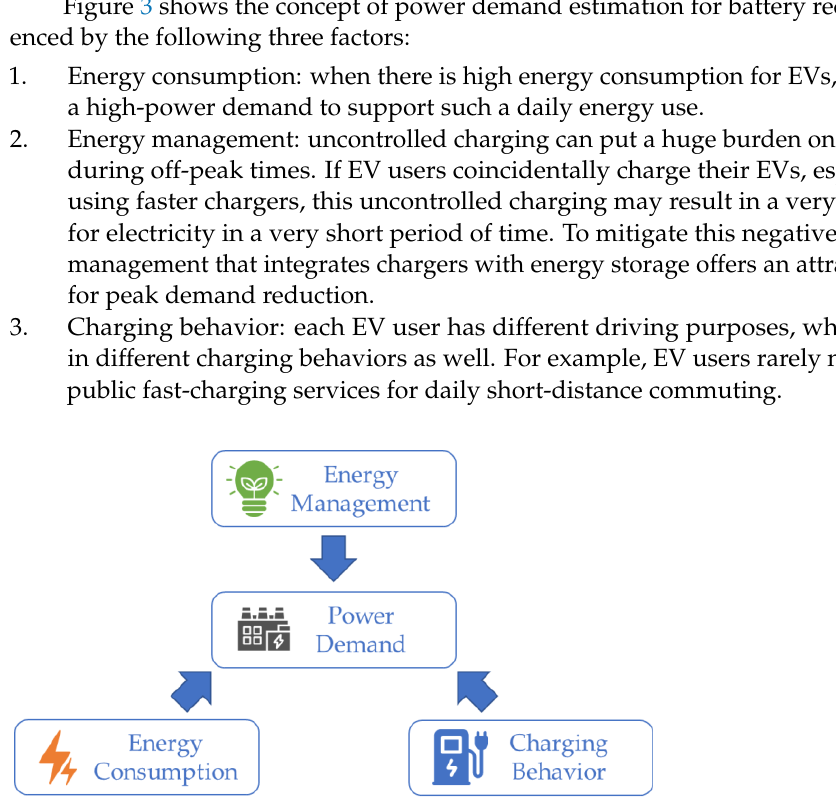
Figure 3. Concept of power demand derivation.